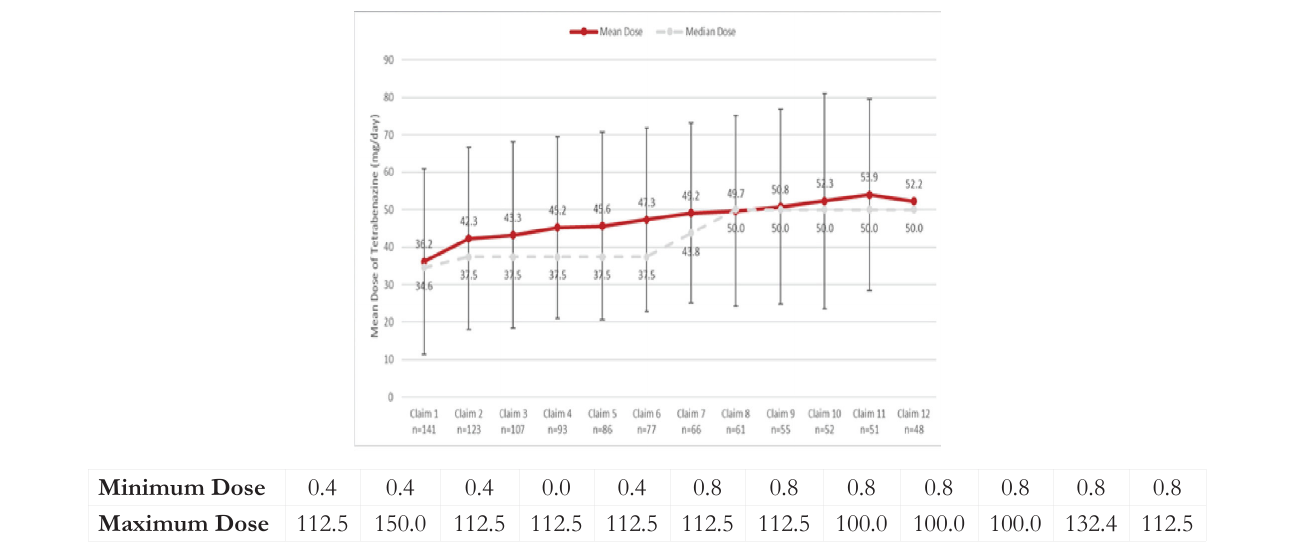
Figure 2. Mean and Median Dose for Claims 1 Through 12